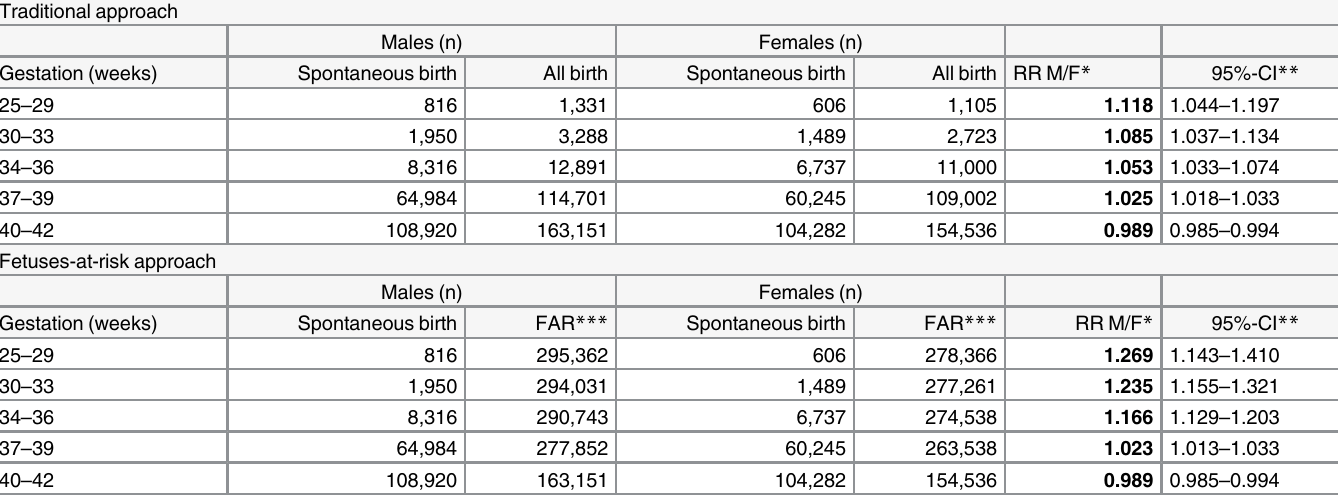
Table 3. Sexual dimorphism for spontaneous birth by length of gestation in categories.